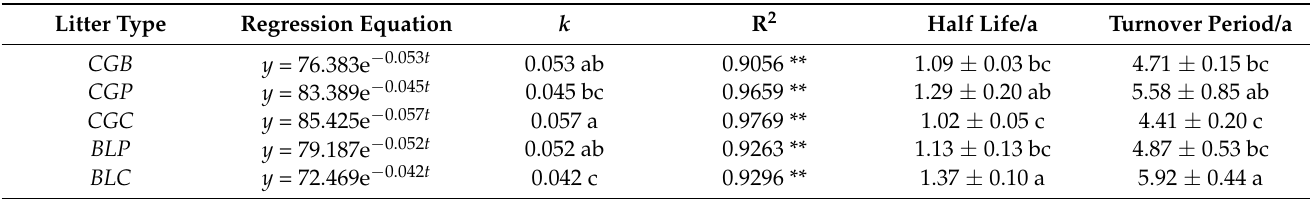
Table 2. Regression decomposition model of dry matter mass loss of different leaf